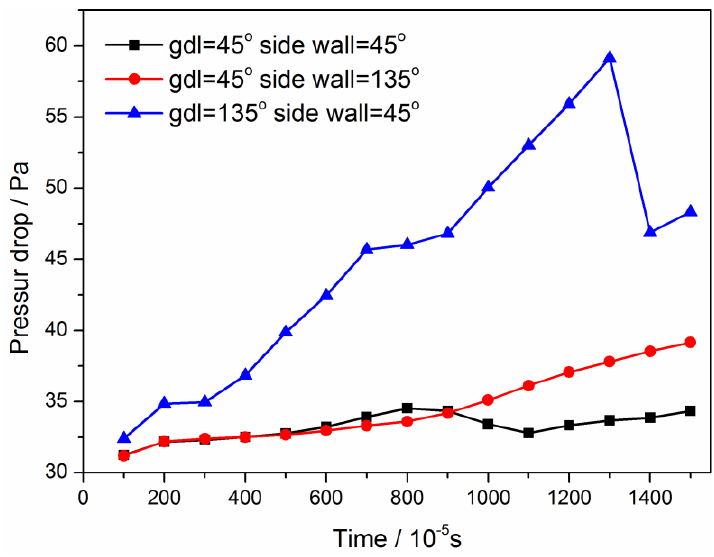
Figure 20. Pressure drop.